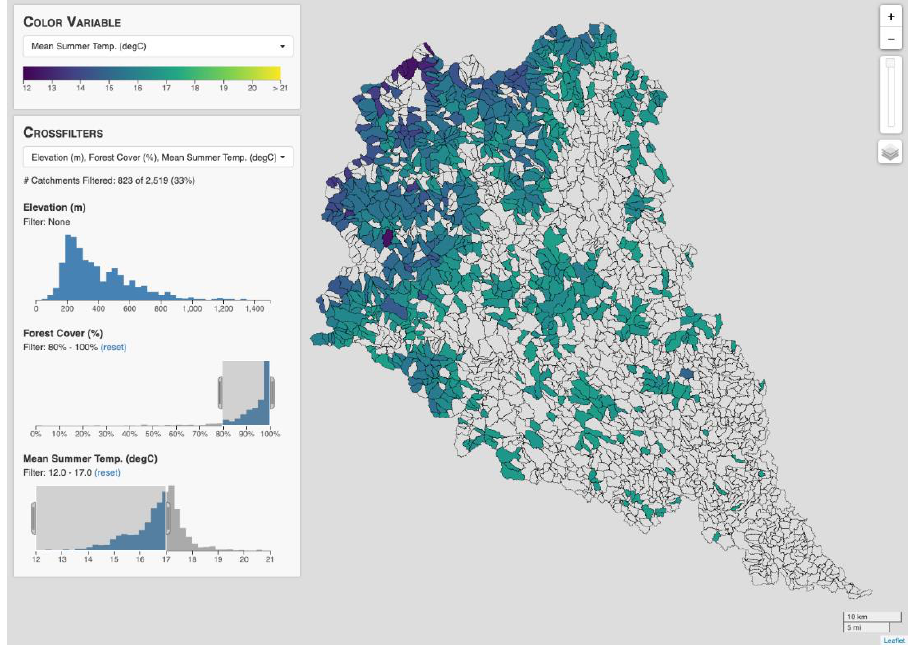
Figure 3. Screenshot showing the use of crossfilters to select catchments with forest cover greater than 80% and a mean summer stream temperature less than 17 °C.